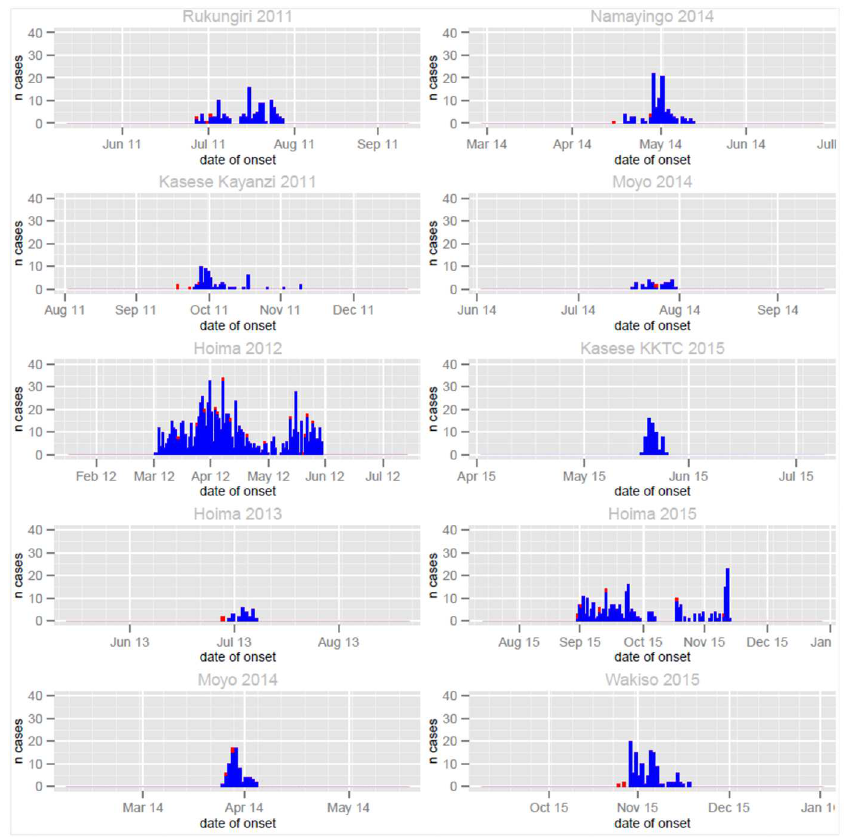
Fig 7. Cholera cases and deaths by year of the outbreak in the fishing villages, 2011–2015. Legend: blue color, suspect cholera cases; red color, cholera deaths.